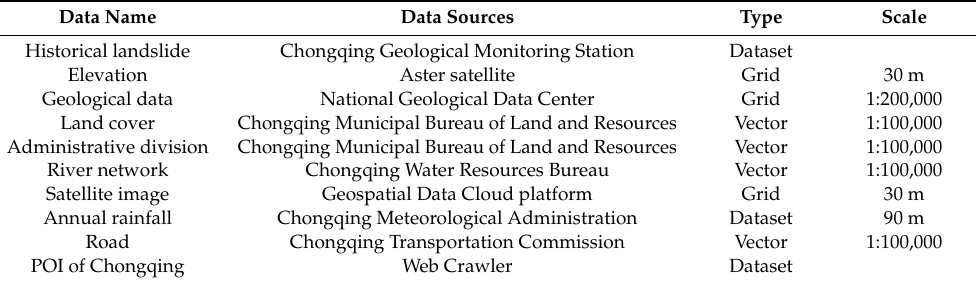
Table 2. Data and data sources.